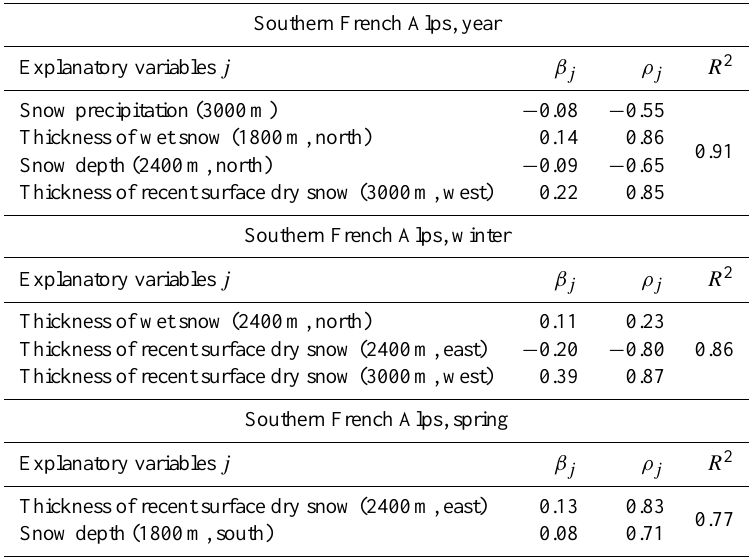
Table 3. Regression model characteristics for the southern French Alps (all year, winter and spring periods). For each retained explanatory variables X norm , β j is the corresponding weighting coefficient in the model; ρ j is the correlation coefficient between X norm jt composite index; and R 2 is the determination coefficient of the model.